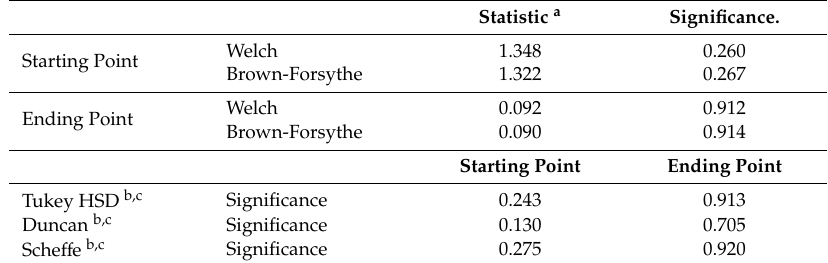
Table 2. Robust and post hoc tests and results for consumers’ agreement / disagreement on the use of